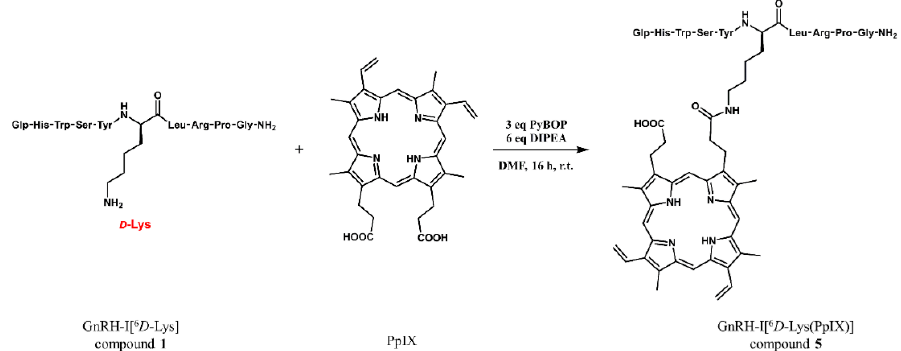
Figure 2. Kaplan–Meier survival curves. ( A ) Correlation between GnRH-R expression and disease- specific survival showing the 3 scores groups—low, moderate, and high expression ( p = 0.556); ( B ) Correlation between GnRH-R expression and disease-specific survival showing the dichotomized scores groups—low and high expression ( p = 0.423).